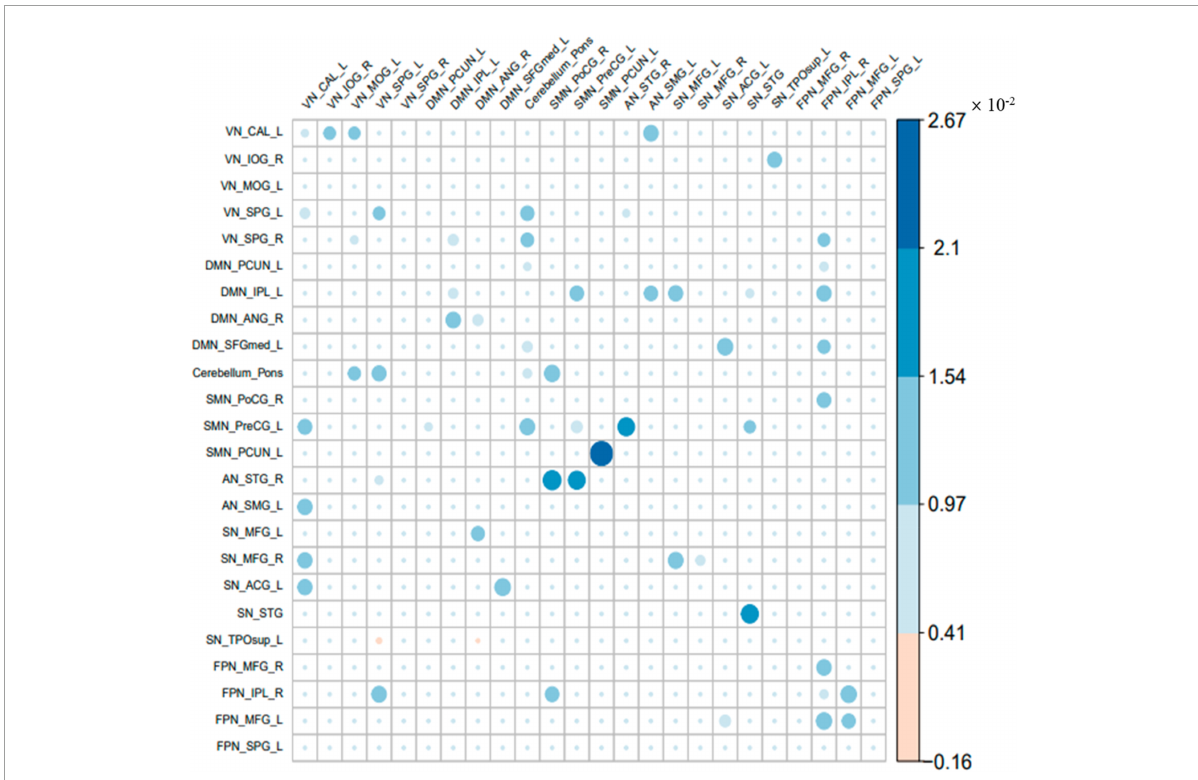
FIGURE3 The common part of the effective connectivity between the two groups. The size of the circle indicates the size of the effective connectivity